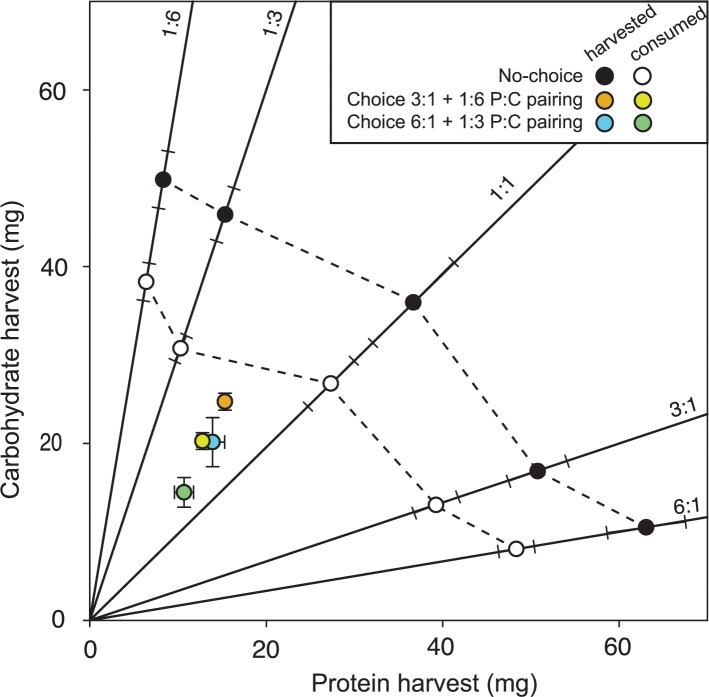
Nutritional geometry in two dimensions.In a choice experiment lasting 12 days, colonies reliably harvested and consumed a slightly carbohydrate-biased 1:1.5 P:C intake target in both choice diet combinations. In a no-choice experiment, colonies exhibited a generalist equal distance intake array (dashed lines) by harvesting similar excesses of protein and carbohydrates relative to their intake target. Diet consumption (subtracting scattered and hoarded amounts from harvested diet) tightly matched diet harvest. Solid black lines show nutrient rails for each no-choice P:C diet treatment. Choice experiment harvest values are provided with bi-directional error bars, and no-choice harvest values provided with pythagorean standard error bars aligned with the intake rail (as per [62]).